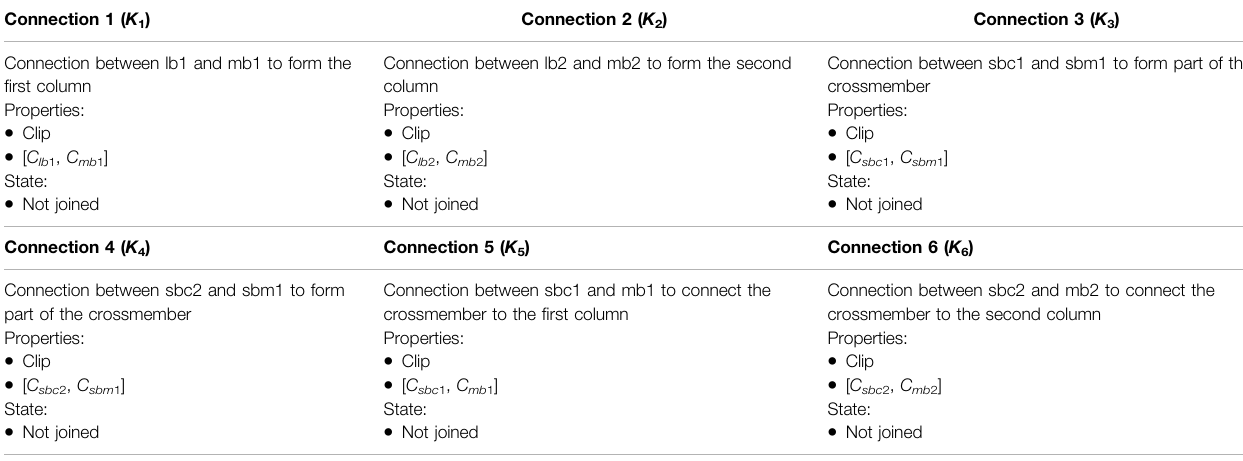
TABLE 3 | SAPD joint de fi nitions for the arch assembly project.